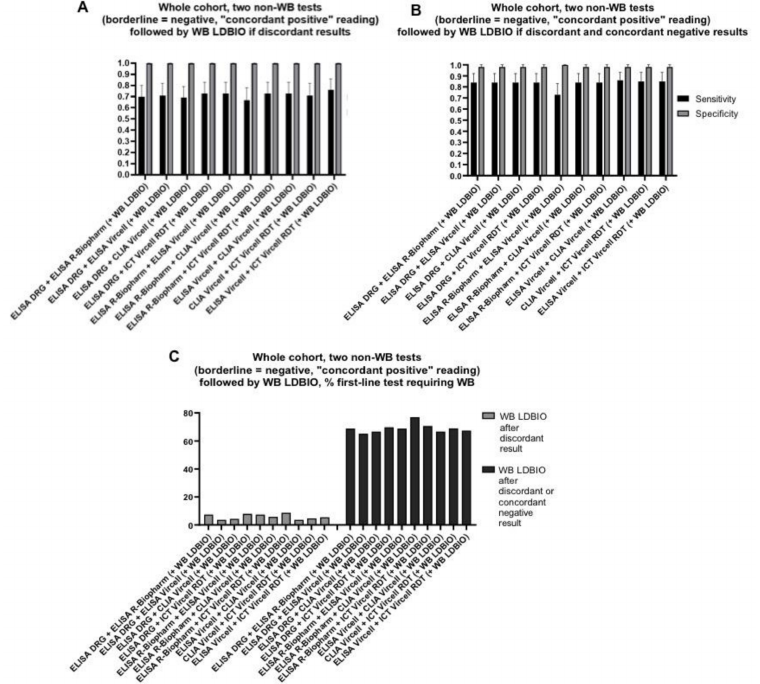
Figure 5. Diagnostic performance of the combination of two first-line non-WB assays